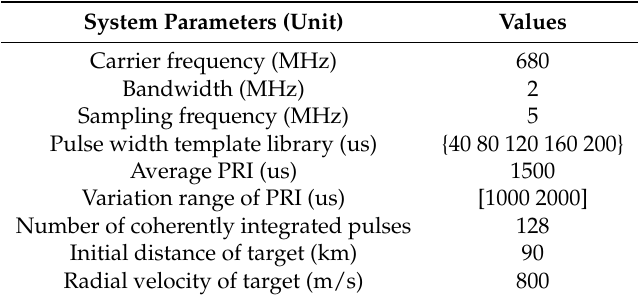
Table 1. Simulated